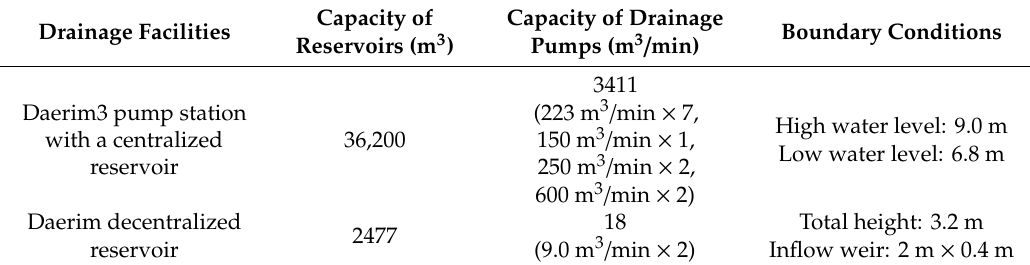
Table 2. Information on the centralized and decentralized reservoirs.